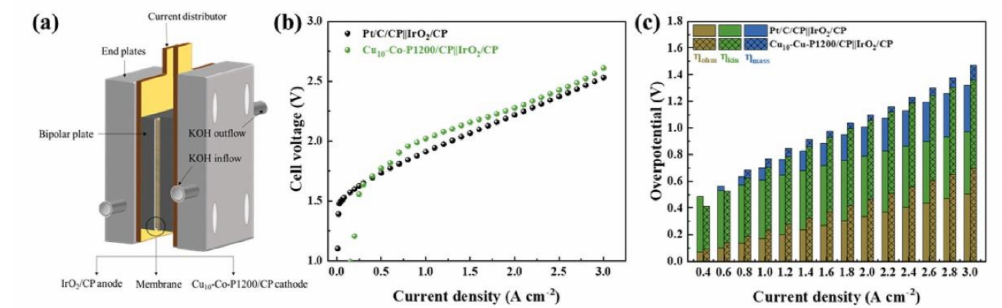
Figure 6. ( a ) Schematic illustration of AEMWE single-cell configuration. ( b ) Polarization curves of AEMWE single cells with IrO2/CP anode coupled with a commercial Pt/C/CP or Cu10–Co–P1200/CP cathode. ( c ) Overpotential subdivisions of ( b ). Reprinted from [66] with permission from